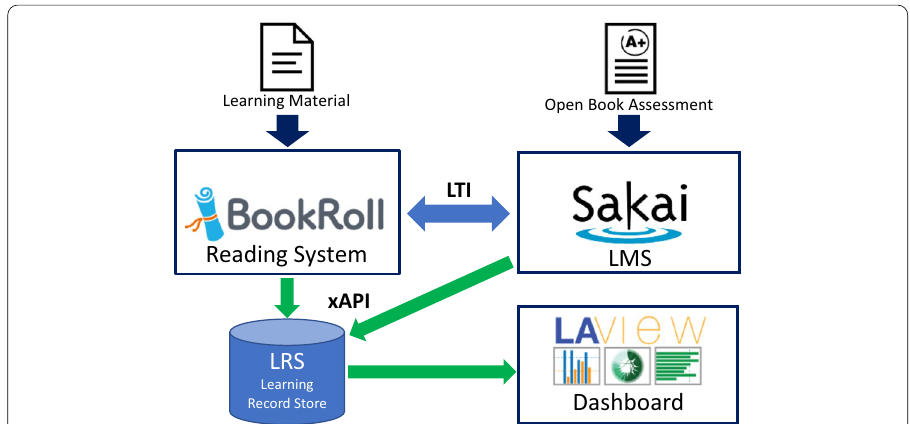
Fig. 4 An overview of the learning system used for data collection